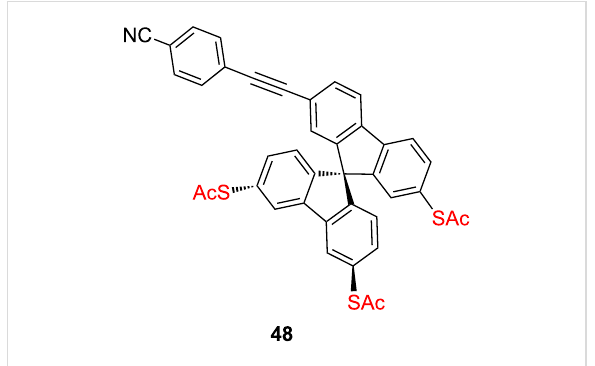
Figure 25: Structure of the rigid 9,9’-spirobifluorene platform 48 .